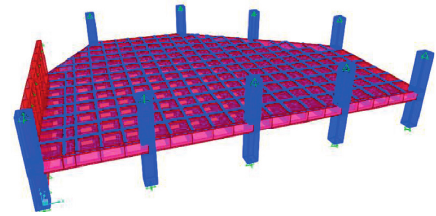
Figure 6: FEM of the composite floor.